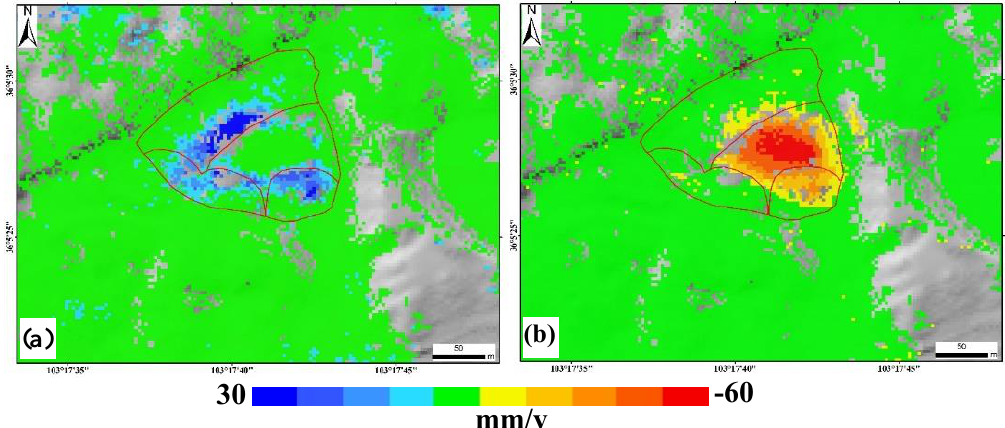
Figure 2. Annual deformation rates in line-of-sight direction calculated with SBAS technique. (a) ascending TerraSAR data and (b) descending TerraSAR data